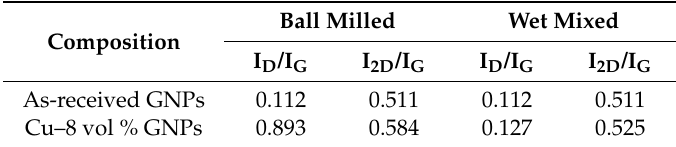
Table 1. Raman data of as-received GNPs and Cu/GNPs after wet mixing and ball milling. Ball Milled Wet Mixed Composition Composition I D /I